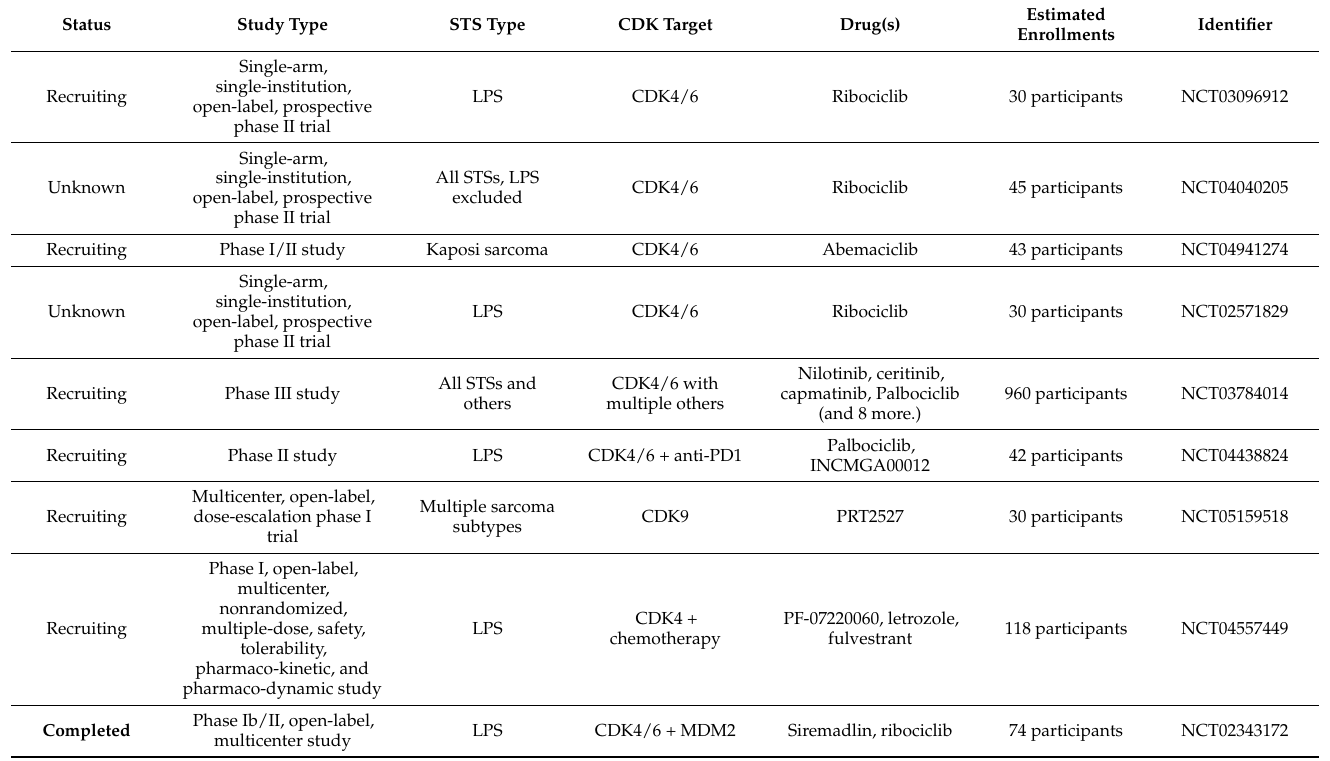
Table 1. Registered ongoing and completed clinical trials with CDK-targeted therapy in STSs (www. clinicaltrials.gov (accessed on 30 June